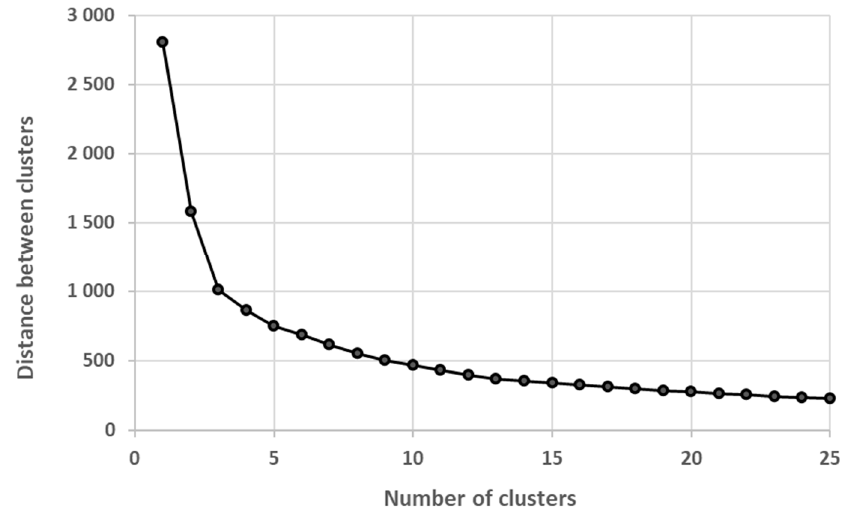
Figure 2. Distance between clusters throughout successive agglomerations. Values are only shown up to 25 clusters to facilitate visual analysis. Table 2. Descriptive statistics for the values of the three fire regime parameters in each clustering solution. CPAB—cumulative percentage of area burned; AWWF—area-weighted wildfire frequency; GCI—Gini Concentration Index; SD—standard deviation.